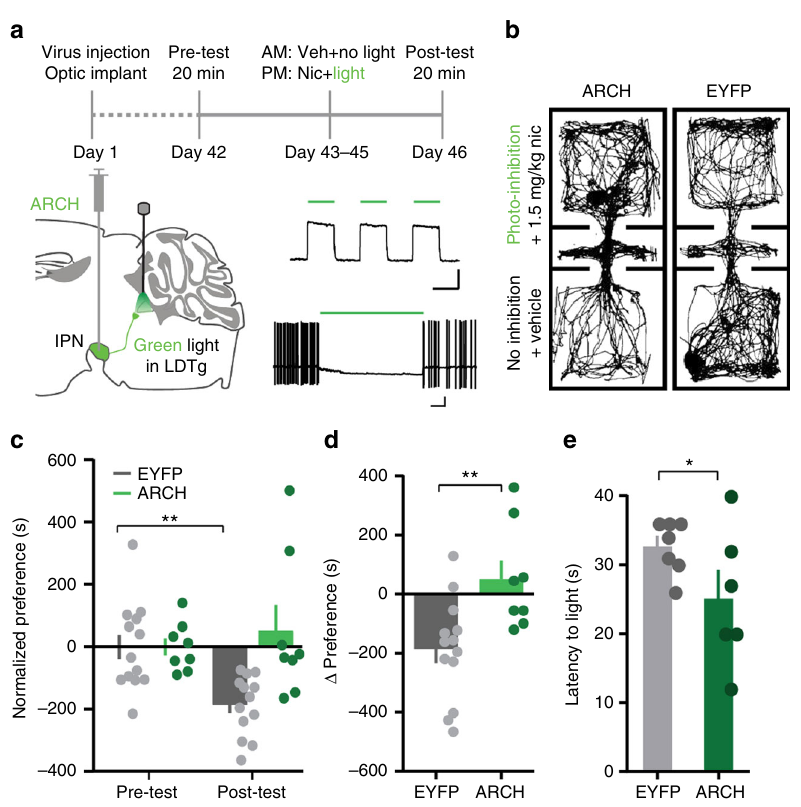
Fig. 4 Inhibition of IPN terminals in LDTg blocks nicotine conditioned place aversion. a Upper: experimental timeline. Lower left: schematic of viral expression and fi ber implants. Right: functional expression of ARCH, (500 ms, 100 pA; 2 sec, 5 mV scale). b Representative plots of animal position during post-test. c Normalized average preference scores; two-way RM ANOVA with Bonferroni post-hoc: P = 0.0022, EYFP n = 13 mice; ARCH n = 8 mice. d Change in preference for nicotine-paired side after conditioning: unpaired t -test (two-tailed), t 19 = 3.018, P = 0.0071. e Latency to enter bright side; unpaired t -test (one-tailed), t 11 = 1.858, P = 0.0450, EYFP n = 7, ARCH n = 6 mice. Data presented as mean ± SEM, ** P < 0.01, * P <